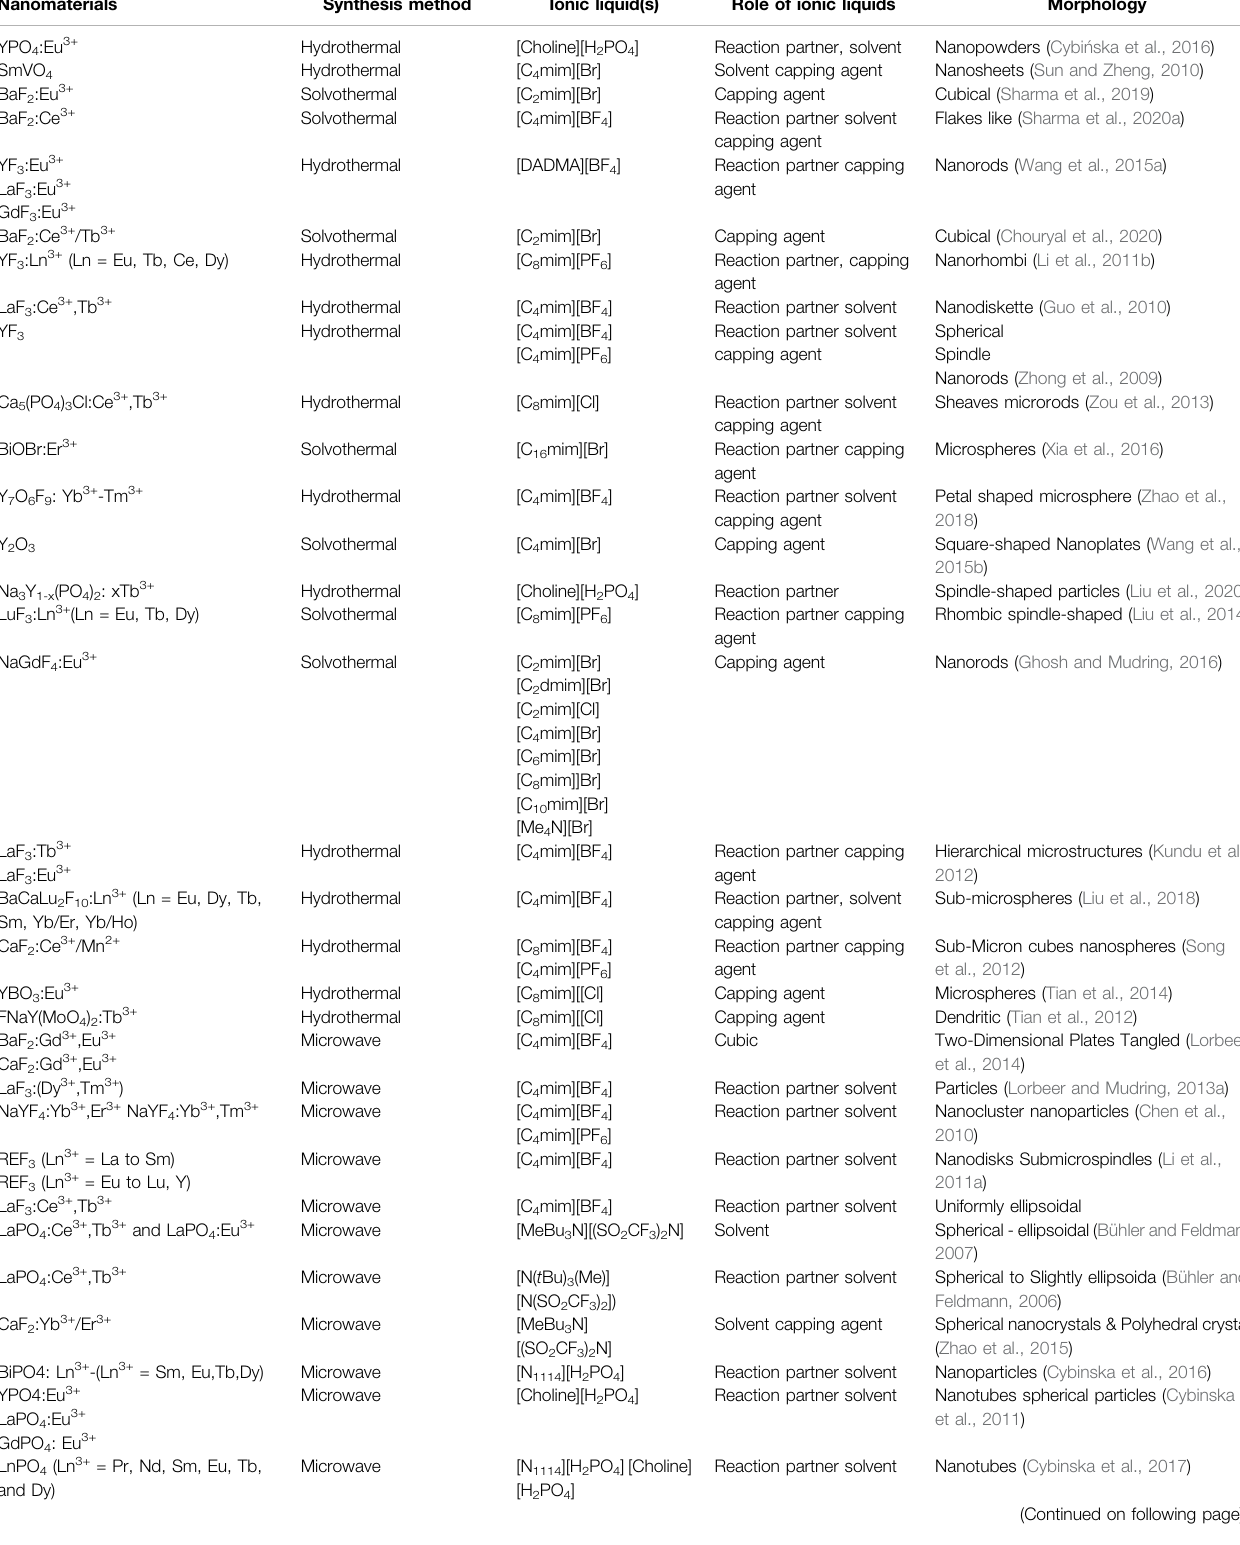
TABLE 2 | Nanomaterials, synthesis methods, ionic liquids, role of ILs, and morphology of nanoparticles.